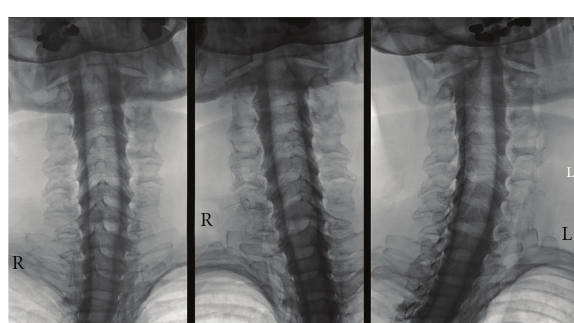
Figure 5: Cervical myelography (prone position). With the patient’s head reclined, there is su ffi cient time to acquire images that show the cervical nerve roots in high detail without losing contrast. (Standard projections as Figure 3).